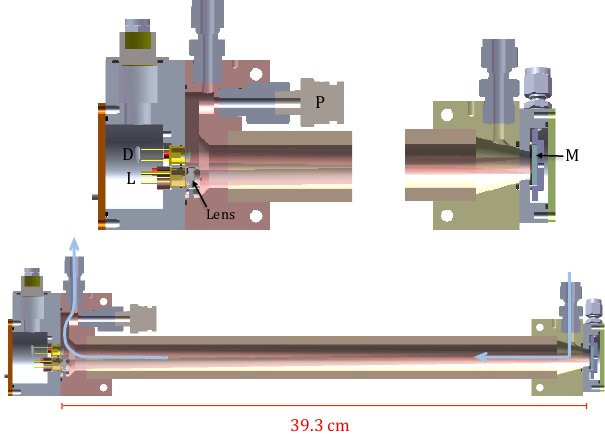
Figure 3. Schematic of a NOAA Water instrument optical absorp- tion cell. Arrows indicate the direction of flow through the cell. The laser (L), detector (D), collimating lens assembly (Lens), and pres- sure transducer (P) are visible in the detail on the left (outlet), and the mirror (M) assembly is indicated in the detail on the right